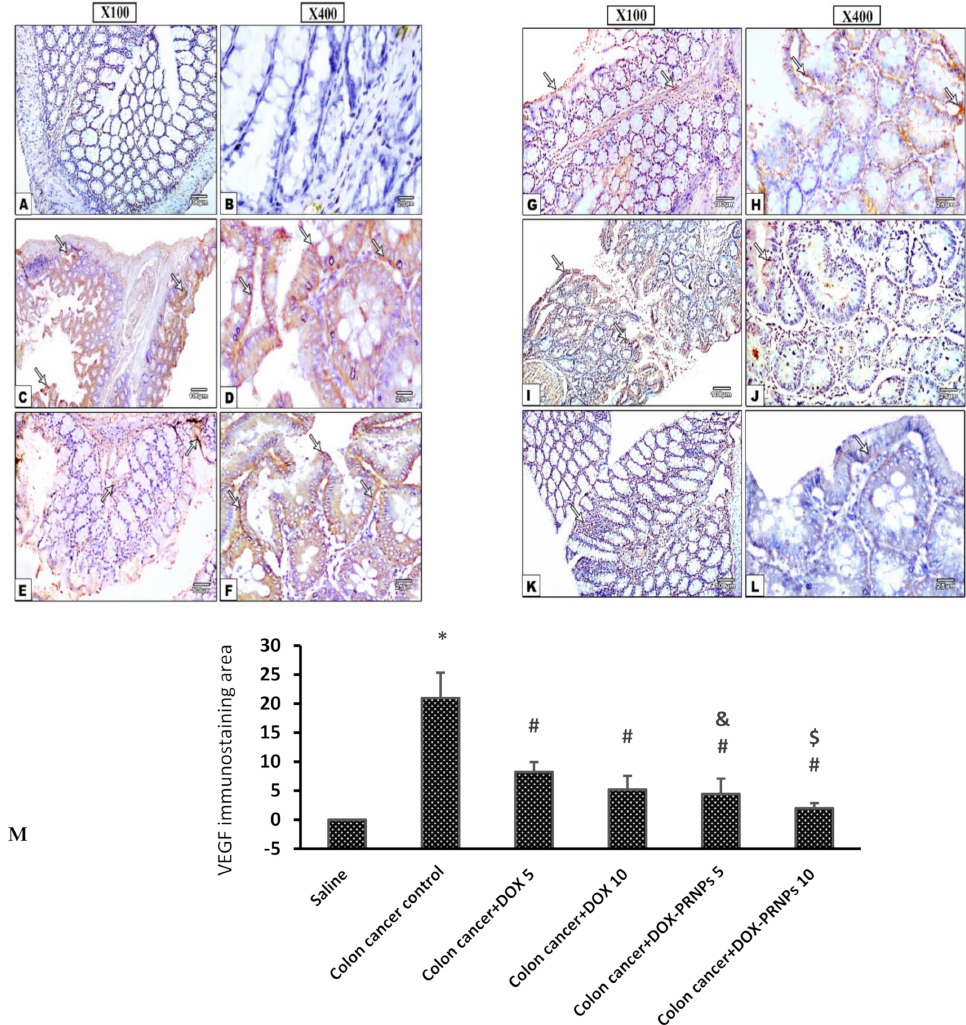
Figure 9. Microscopic pictures of immunostained colonic sections against VEGF. Images show nega- tive expression of colonic mucosa in the saline group ( A , B ). Control group ( C , D ) presents marked brown positive expression in afflicted colonic mucosa of cancer colon (white arrows), while DOX 5 and 10 and DOX-PRNP2 5 and 10 mg/kg treated groups ( E – L ) indicate mild brown positive expres- sion in affected mucosa (white arrows). Mayer’s hematoxylin was used as counterstain with IHC. Magnifications of VEGF immune stain X100 bar 100, X400 bar 25. ( M ) Column chart representing mean ± SDM for area % of VEGF immunostaining, *: versus saline group, #: versus colon cancer control, &: versus colon cancer + DOX 5 mg/kg and $: versus colon cancer + DOX 10 mg/kg, p < 0.05. PRNPs: PRNP2 prepared from hydroxypropyl methyl cellulose phthalate HP55